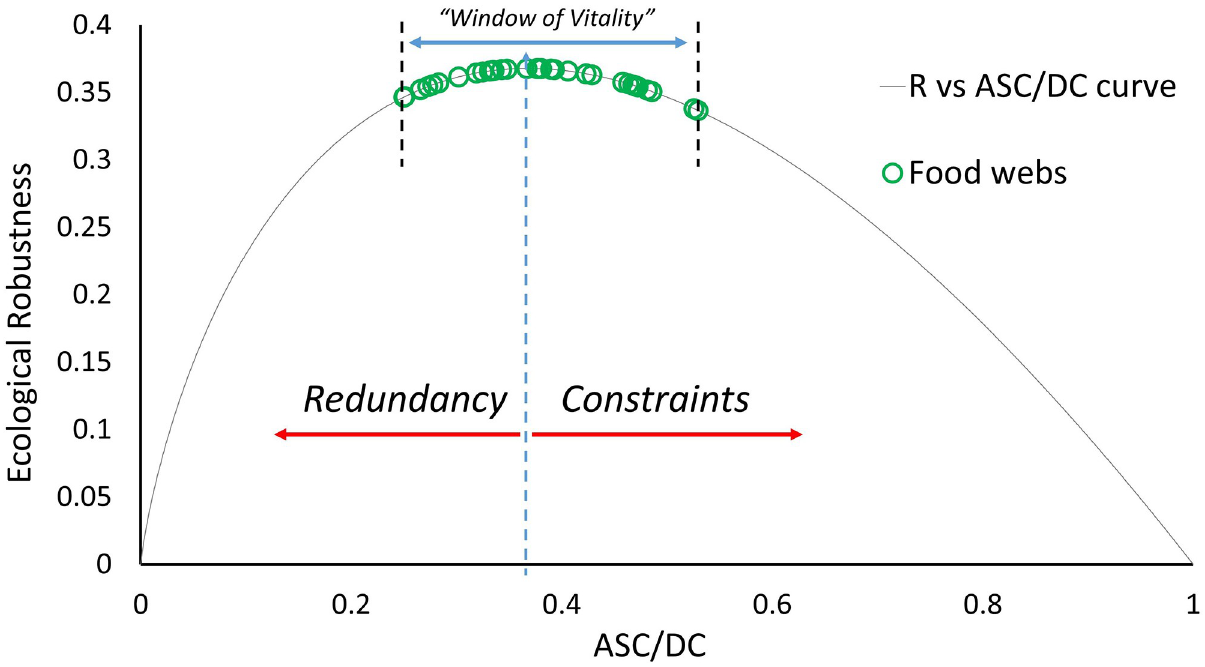
Fig 3. Ecological robustness plotted against the ratio ASC/DC . Thirty eight food webs taken from the datasets of [32] are plotted on the curve fit, illustrating the “window of vitality” that most ecosystems reside in. The peak of the curve corresponds to a R value of 0.368 and an ASC/DC value of 0.368. Figure used with permission from